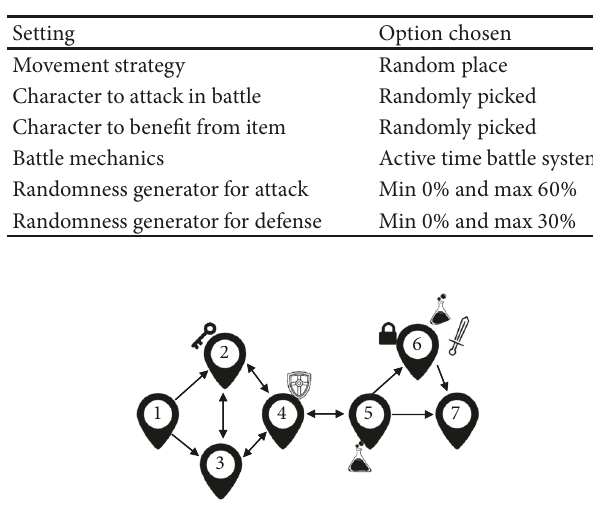
Table 2: Foes and items at each place. Table 3: Simulation settings.